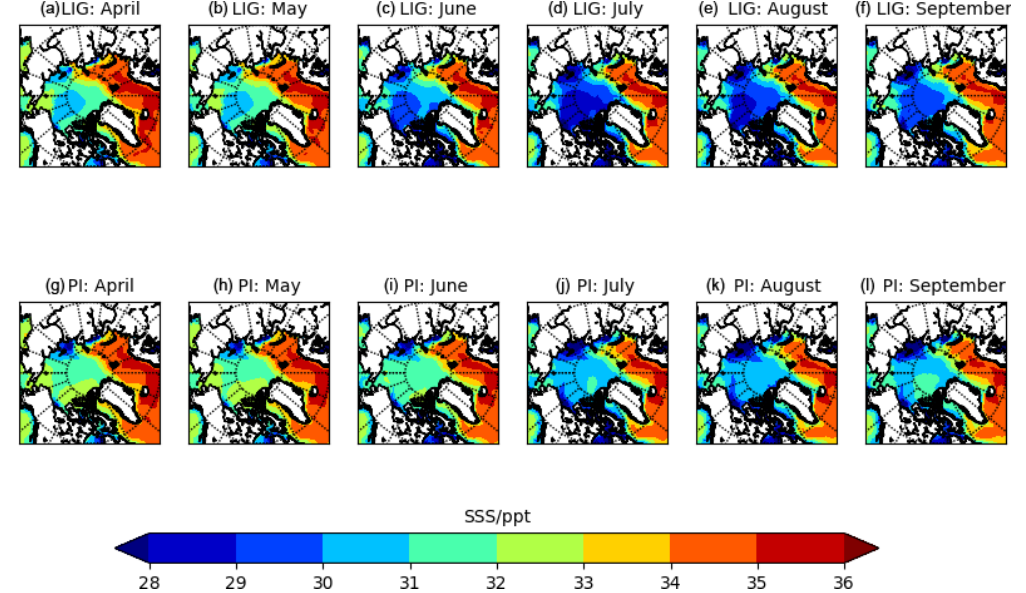
Figure 3. Mean sea surface salinity (in parts per thousand, ppt) for the LIG and PI. The 200-year mean over the Northern Hemisphere for each month from April–September is shown, computed as the time average from monthly model